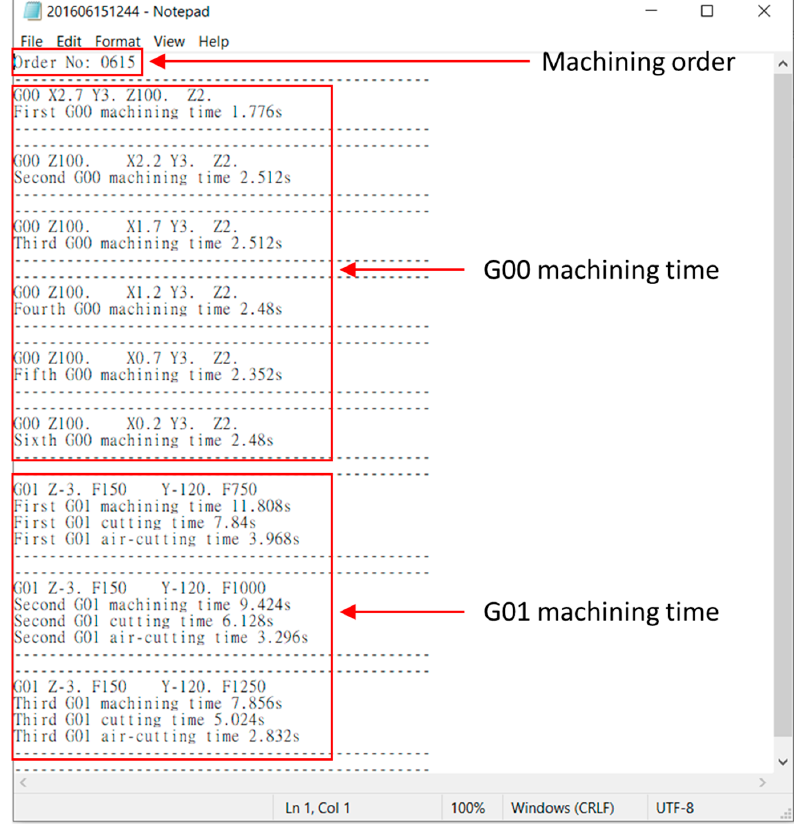
Figure 4. Output txt file of the air cutting monitoring system.